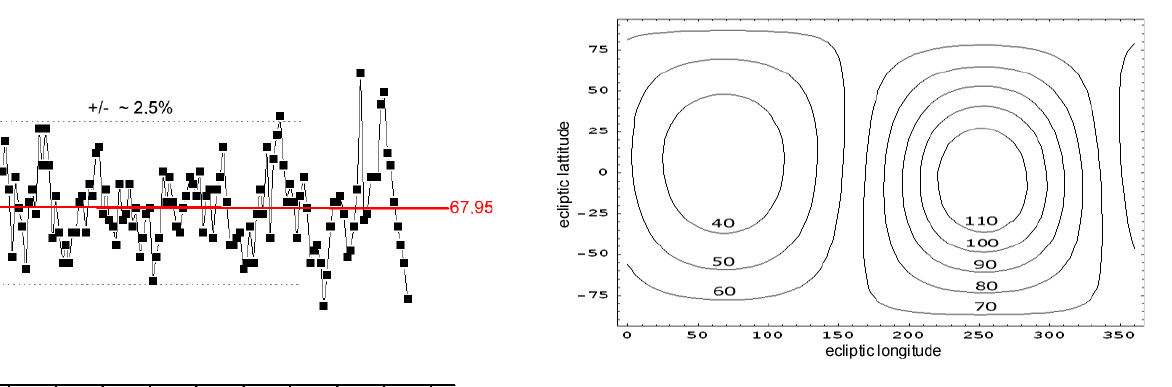
Fig. 2. Calculated interplanetary Ly- α -background intensity map in Rayleigh for 11 June 2008 based on the model by Wu and Judge (1979) with n H , LISM = 0 . 1cm − 3 , 10.7cm ra- dioflux=68 [ 10 − 22 Wm − 2 Hz − 1 ]